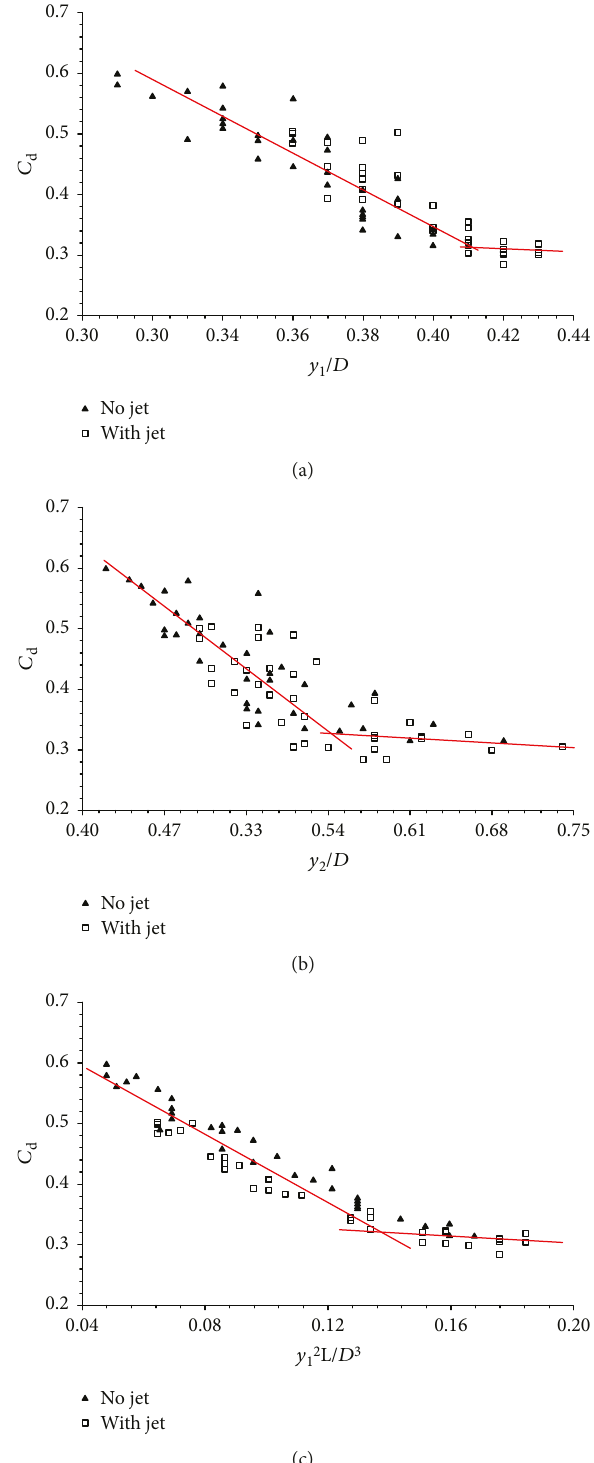
Figure 19: Drag coe ffi cients in 72 cases of the pure spiked bodies and the spiked bodies with sonic sideward jets: (a) vary with the parameter y / D ; (b) vary with the parameter y 1 the combined parameter y 12 L / D 3